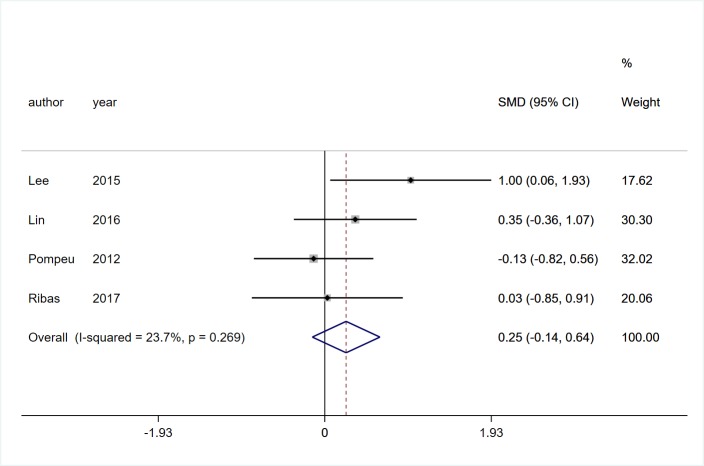
Forest plot of ADL.